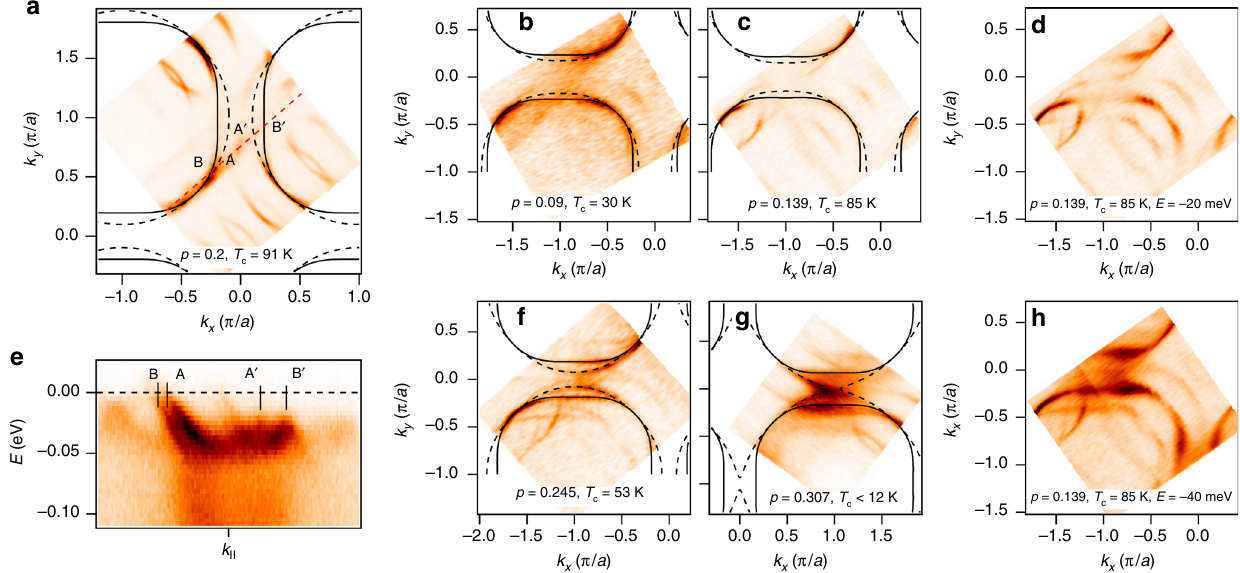
Fig. 1 Development of the electronic structure of Bi 2 Sr 2 CaCu 2 O 8 + δ at the Fermi level with doping. a Fermi surface of an as grown sample. b , c Underdoped samples, obtained by annealing of the as grown samples in vacuum. f , g Overdoped samples, obtained by annealing of as grown samples in O 3 . Spectral intensity, represented by the false color contours, is integrated within ±2.5 meV around the Fermi level. Solid (dashed) lines represent the bonding (antibonding) states obtained from the tight-binding approximation that best fi ts the experimental data. The fi tting involved the lines connecting the experimental minimal gap loci in all cases where the underlaying Fermi surface was gapped, as indicated in e . e Dispersion of states along the red dashed line in a . Fermi momenta of bonding (B, B ′ ) and antibonding (A, A ′ ) are marked in both a and e . Gapped Fermi momenta (A ′ , B ′ ) were approximated by the points where the dispersion acquire maximum. d Intensity contour for sample UD85 (from c ) at E = − 20 meV and h E = − 40 meV. The area enclosed by the TB lines that best represent the experimental data is calculated and used for determination of the doping parameter p A . The superconducting transition temperature, T c , is determined from magnetic susceptibility measurements (as grown and underdoped samples) and from ARPES data, as explained in the text. All the maps were recorded at 12 – 20